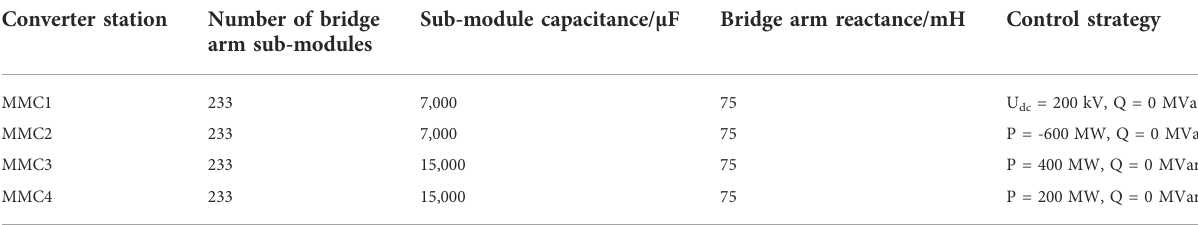
TABLE 1 Converter station